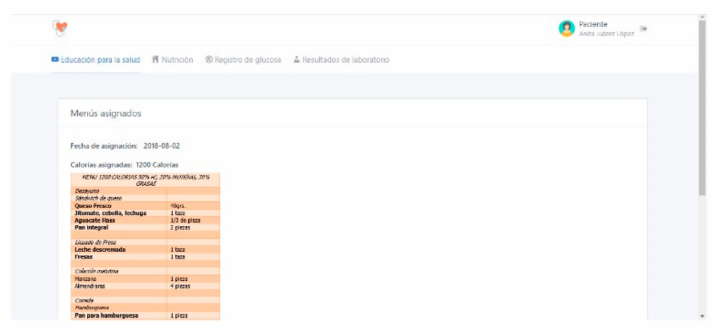
Figure 41. Patient application interface: List of food groups and suitable rations that can be consumed.